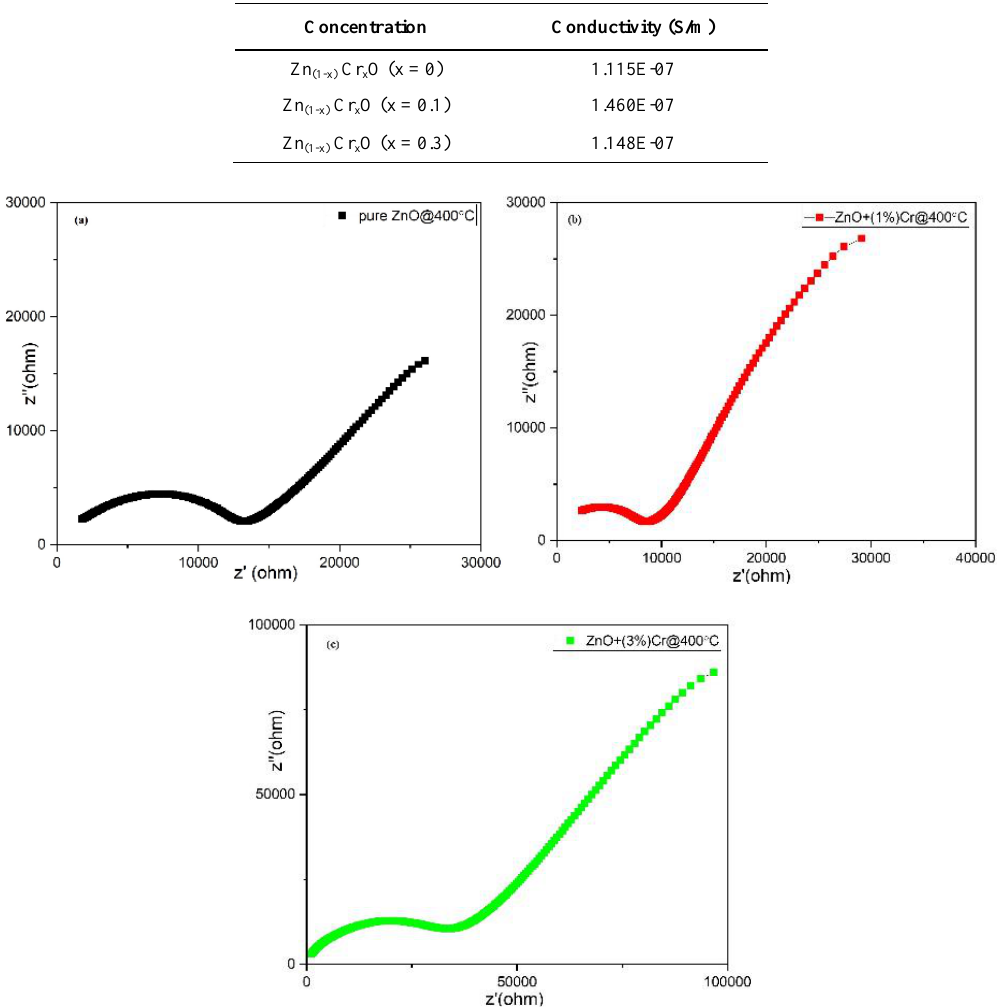
Figure 6. (a), (b) and (c) Cole-Cole plot of Zn (1-x) Cr x O (x = 0, 0.1and 0.3) nanoparticles